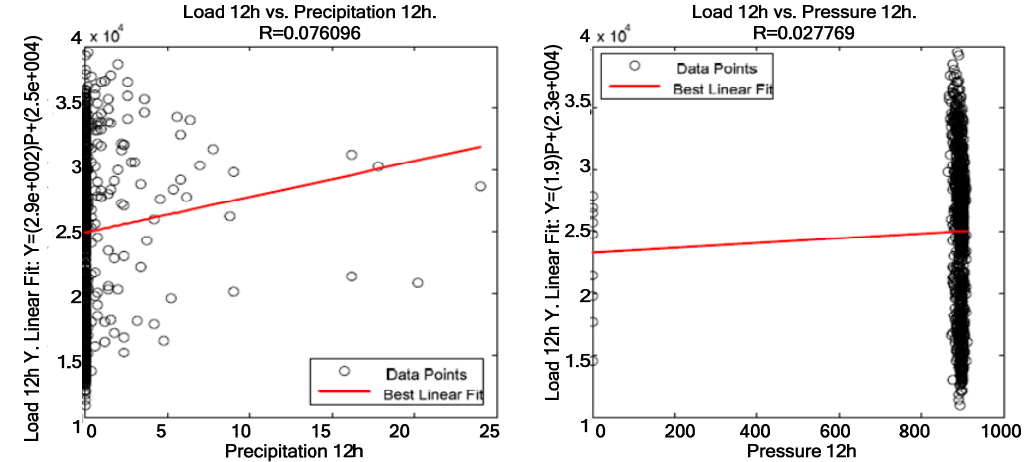
Figure 7. Correlation among precipitation, pressure and electric power consumption at 12 h.